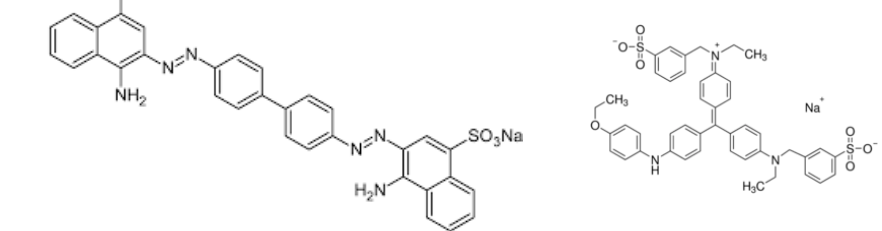
Figure 1. Chemical structures of methylene blue, congo red and brilliant blue R.